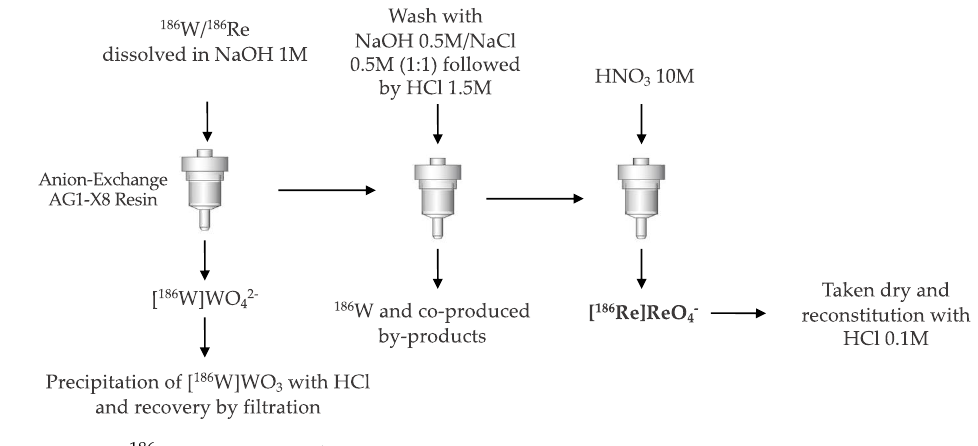
186 Re processing Figure 2. 186 Re processing scheme. Figure 2.